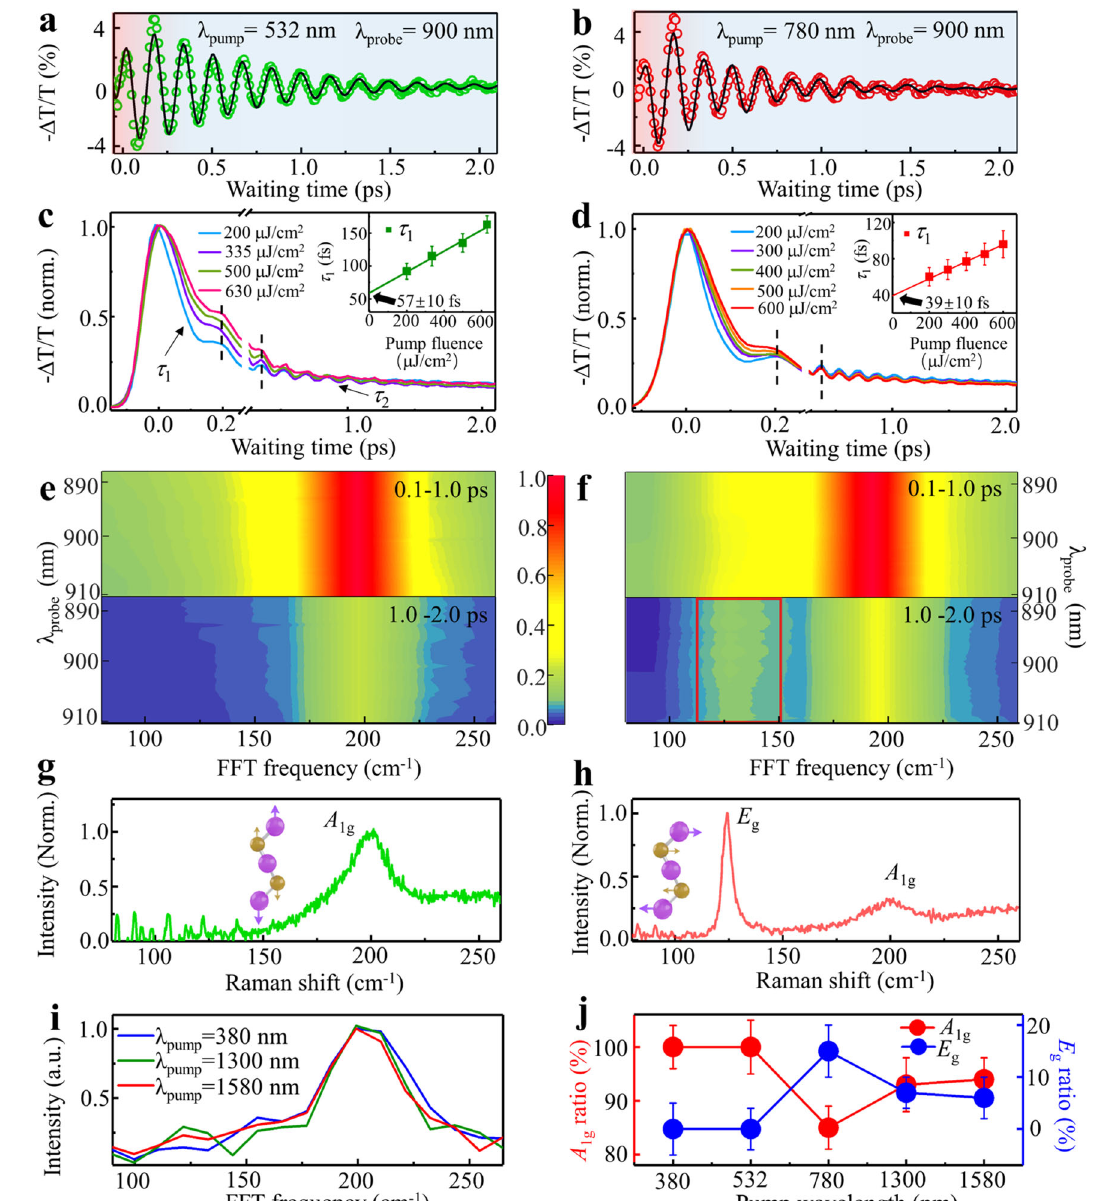
Fig. 3 | The coherent phonon (CP) dynamics, time-resolved IVS, and Raman spectraofaTi 3 C 2 T x fi lmwithdifferentopticalexcitations.a , b CPsignals(green and red circles) were monitored at 900nm after excitation at 532 and 780nm, respectively. The two black lines show fi ts to the CP data. c , d The 532 and 780nm pump fl uence dependent dynamics data were monitored at 900nm. e , f Time- resolvedFFTmapsfor0.1 – 1.0and1.0 – 2.0pswithdifferentexcitationwavelengths. g , h Raman spectra of the Ti 3 C 2 T x fi lm under the 785nm and 532nm pump. i FFT